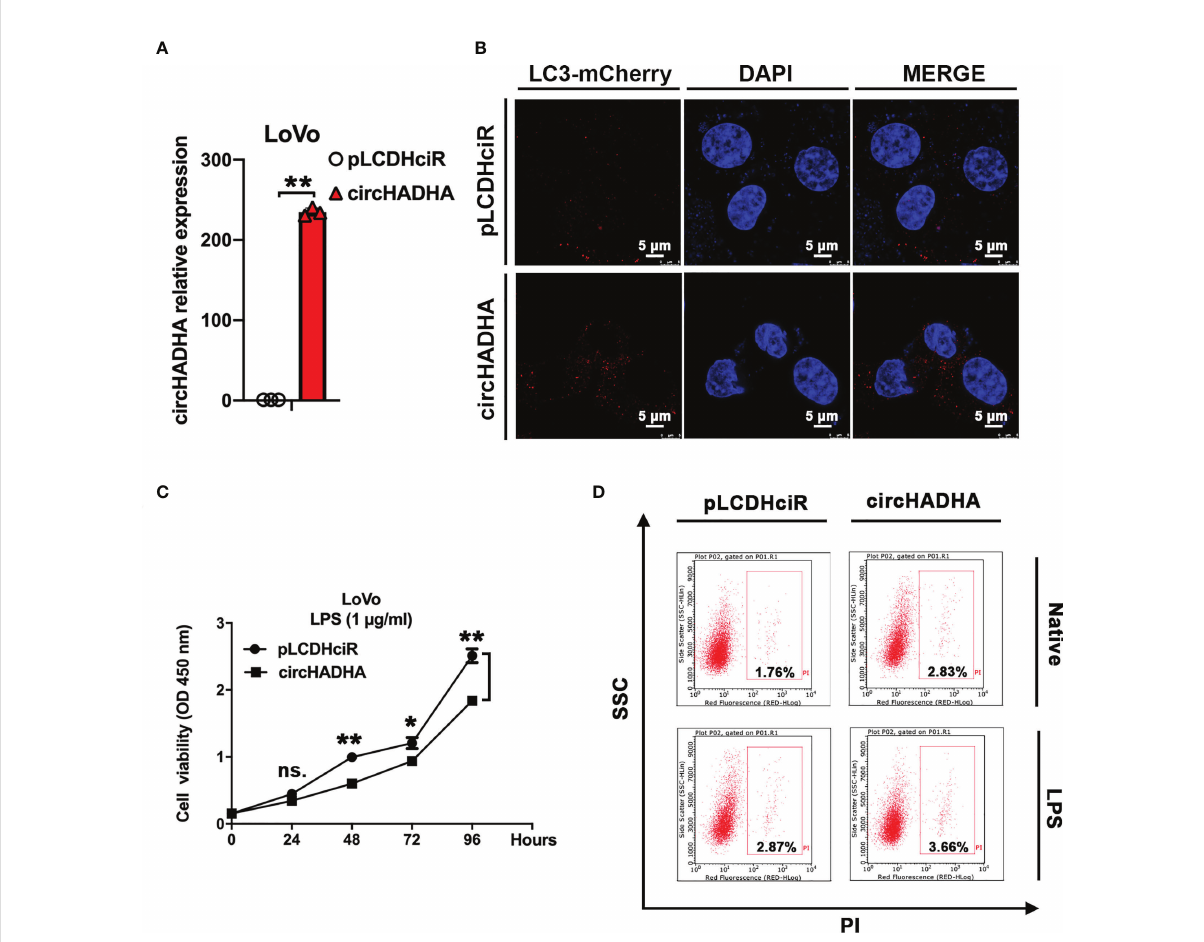
FIGURE 3 CircHADHA regulated autophagy and proliferation in colon cancer cells. (A) The generation of circHADHA overexpressed LoVo colon cancer cells. (B) The LC3B-mCherry-based autophagy assays in LoVo cells. Overexpression of circHADHA promoted autophagy compared with control in LPS-induced LoVo cells. mCherry represented LC3B-positive autophagosomes. Cell nuclei were labeled with DAPI. (C) The measurement of cell viability was performed by CCK-8 assay. Overexpression of circHADHA inhibited proliferation compared with control in LPS-induced LoVo colon cancer cells. (D) Cell apoptosis was performed by fl ow cytometry. No signi fi cant alteration of apoptosis was observed by overexpression of circHADHA compared with corresponding control in LoVo and LPS-induced LoVo cells. Three independent experiments were performed. ** P < 0.01; * P < 0.05; ns, no signi fi cant